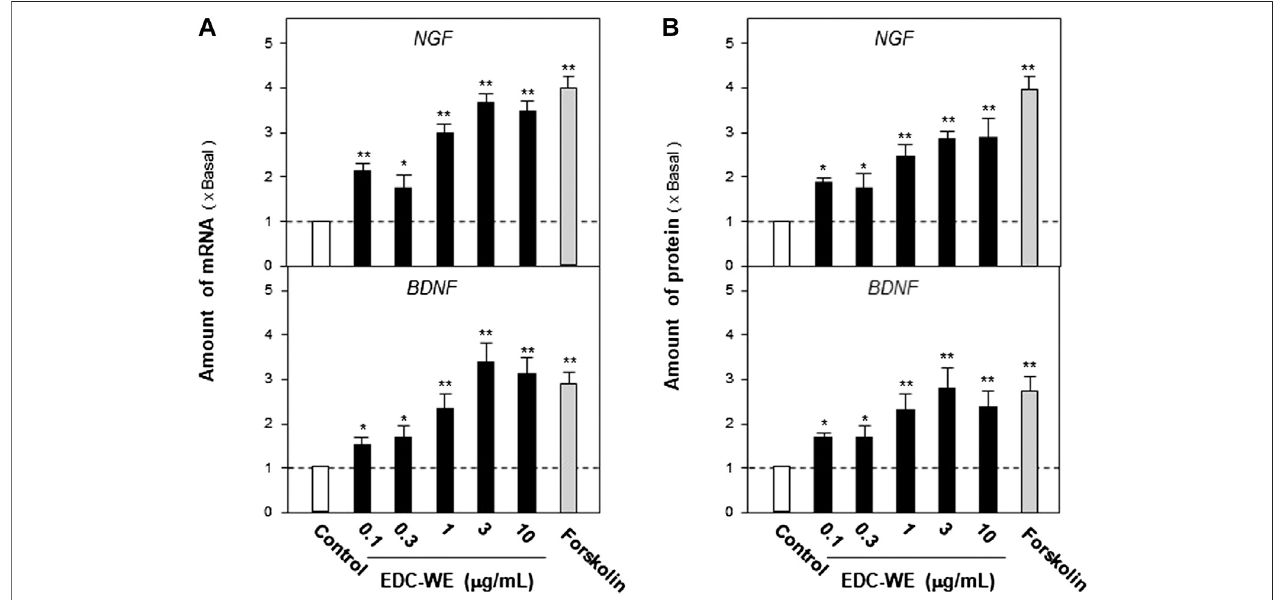
FIGURE 3 | The aqueous extracts of Elaphuri Davidiani Cornu (EDC) increased the neurotrophic factor expression in mouse astrocyte primary cultures. (A) : The primary mouse astrocyte cultures were treated with the aqueous extract (EDC-WE) at 0.1 – 10 μ g/ml concentrations for 24 h. The mRNA expression levels of nerve growth factor and brain-derived neurotrophic factor were determined by qPCR analysis. (B) : The drug treatment with EDC-WE was the same as in (A) and the expression ofnervegrowth factor and brain-derived neurotrophic factor was determined by ELISA. Forskolin (10 μ M) was used to treat the positive-control group. Data are expressed as a fold-change relative to the positive control group (no-drug treatment) as mean ± SEM, where n (cid:1) 5. * p < 0.05, ** p < 0.01 (compared with no- treatment control group).